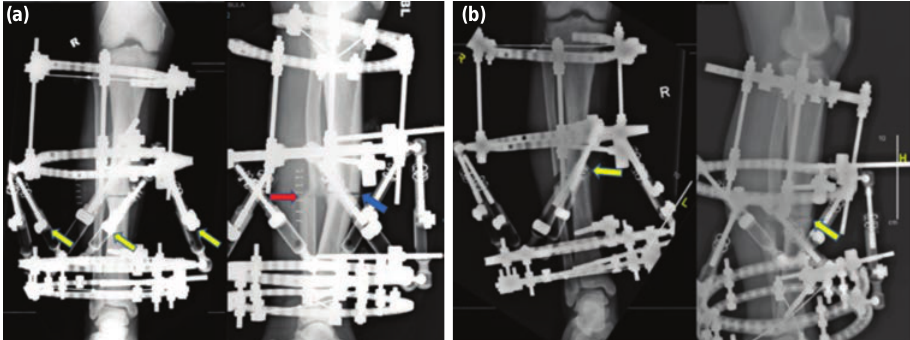
Post-operative radiographs post frame insertion. (a) Immediate post-operation AP and lateral radiographs. Yellow arrows on Fig. 2: the AP radiograph indicate the adjustable telescopic struts. The red arrow on the lateral radiograph indicates the oblique osteotomy that was made to the fibula. The blue arrow on the lateral radiograph shows the compression at the fracture site. (b) AP and lateral radiographs at three months post-operation with the hexapod frame still on. The yellow arrows show the bridging callus formation at the fracture